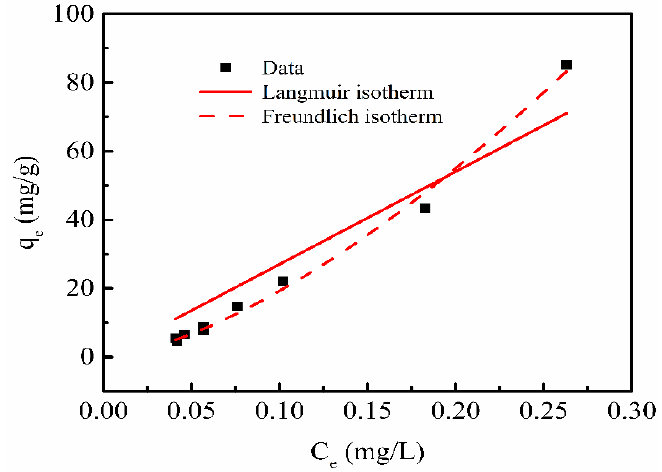
Figure 6. Isotherm data and modeling for the adsorption of TCS on carbon black.